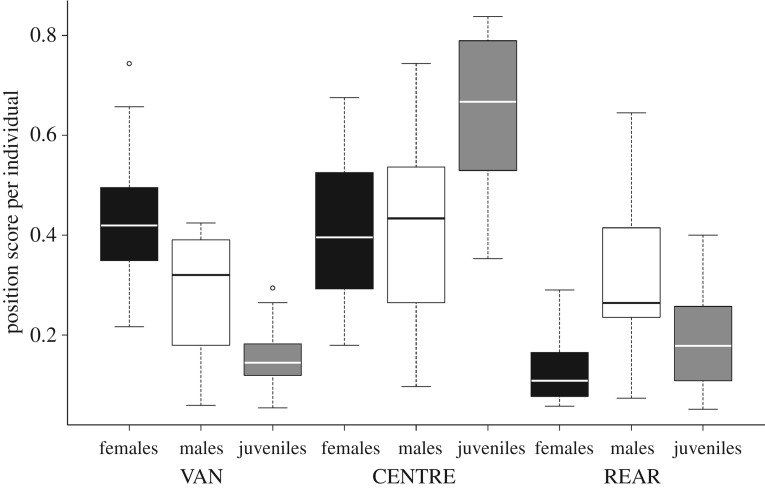
Boxplots of departure positions based on age and sex. Position scores were calculated as the observations of an individual in a position divided by the total number of times the individual was observed in a movement. Females are depicted in black, males in white and juveniles in grey.